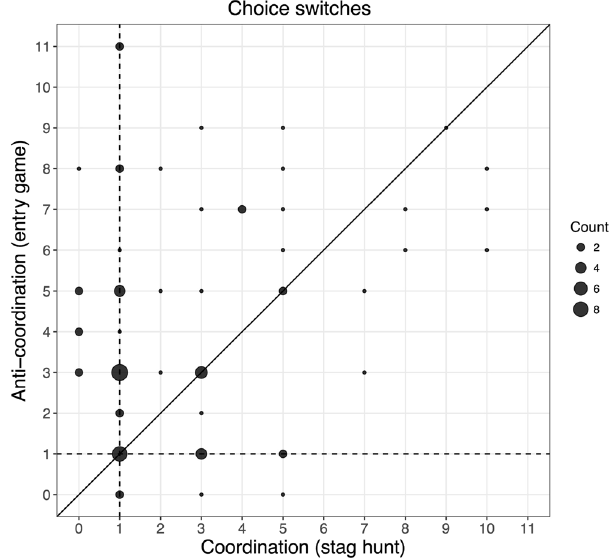
Figure 5. Choice switches in coordination and anti-coordination games (i.e., stag hunts and entry games, respectively). Circle areas indicate how many participants switched a given amount of times between choosing a safe option, as opposed to an uncertain option, as the value of the safe payoff was gradually increased. Observations along the dashed lines represent participants that adopted “perfect threshold strategies” (i.e., only one “choice switch”), in the stag hunts (horizontal dashed line) and in the entry games (vertical dashed line). We observe that perfect thresholds (i.e., one switch) are the modal frequency in stag hunts, used by 42% of participants, while this percentage drops to 19% in entry games (where the modal choice-switch frequency was 3, for 25% of participants). An equal number of choices switches across the two games would have resulted in observations lying on the main diagonal. The figure shows that the majority of participants increased switching frequency when passing from coordination to anti-coordination games, as most observations are above the